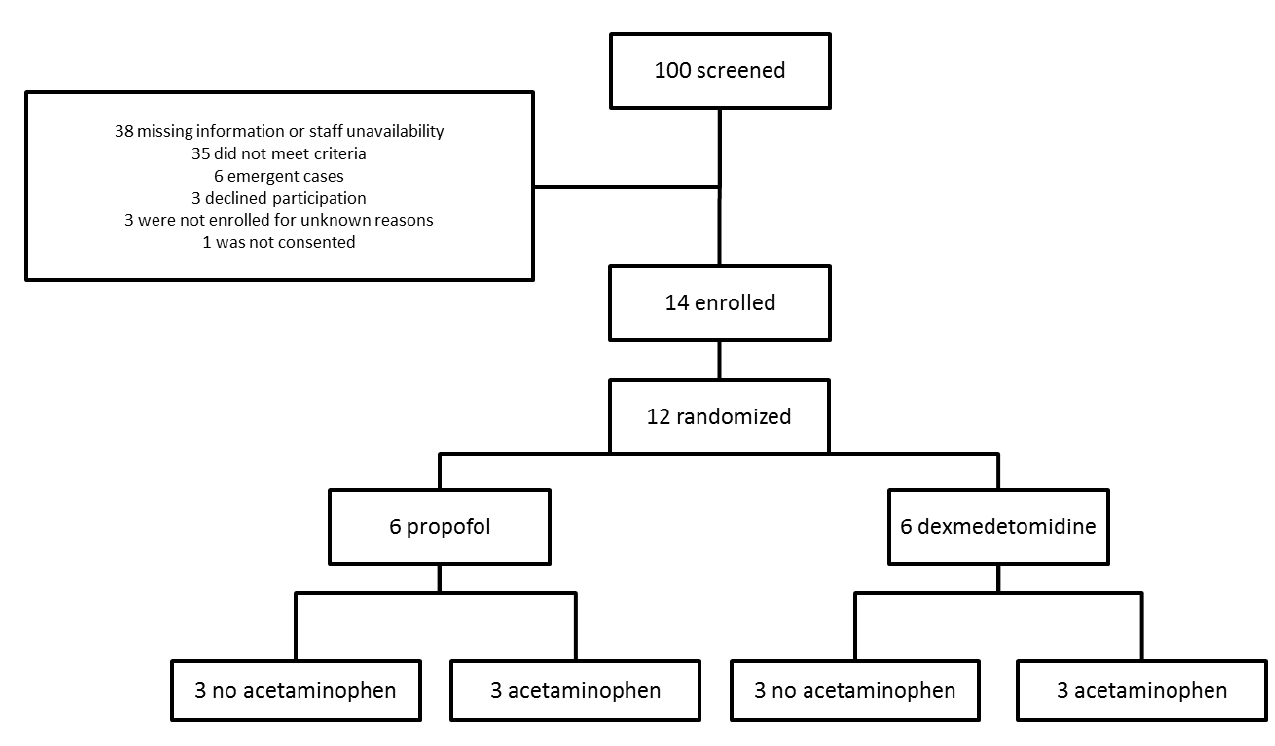
Figure 1. Consort diagram.